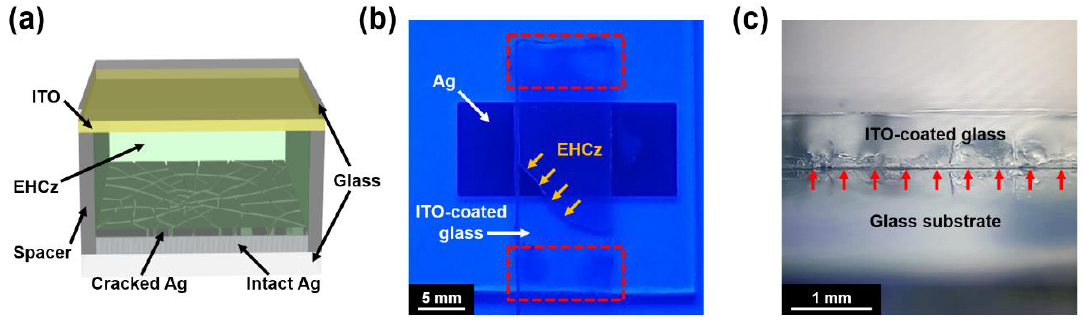
Figure 2. ( a ) Configuration of device to investigate the charge injection properties via local electric field enhancement. ( b ) Photographic image of the device illustrated in ( a ), under 365 nm UV light. The optically excited EHCz material under UV irradiation clearly revealed its liquid boundary during the capillary action (indicated by yellow arrows). Red dashed boxes indicate the locations of silica microsphere spacers. ( c ) Optical microscopy image of a cross section of the device in ( b ). The gap between the two electrodes is indicated by red arrows.